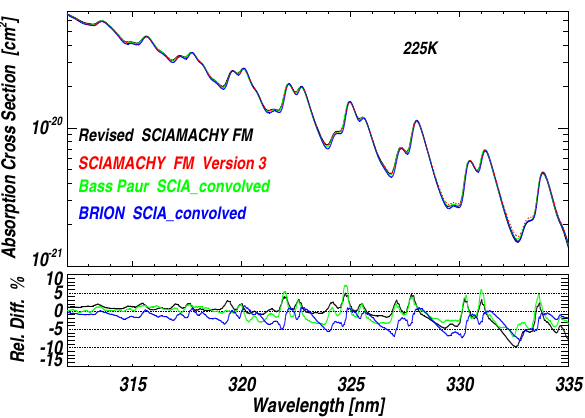
Fig. 6. Comparison between Bogumil et al. (2003) version 3.0 (red), revised (black), Bass–Paur (green) and Brion (blue) in the Huggins band. The amplitudes of the absorption structures of the Bogumil et al. (2003) data at the absorption minima are smaller compared to Bass–Paur, Brion and revised data. The lower sub-panel showa the difference to the Bogumil et al. (2003) data.